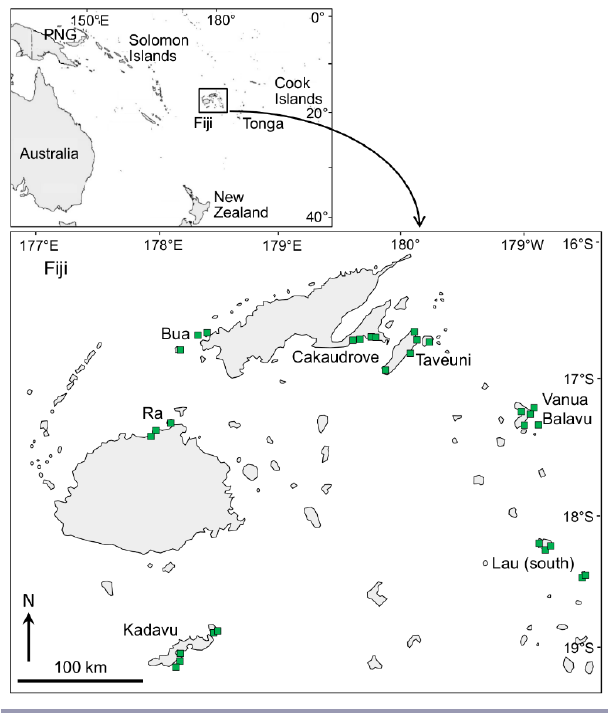
Fig. 1 . Map of Fiji with the 7 locations (annotated) and the 29 study communities (green squares).